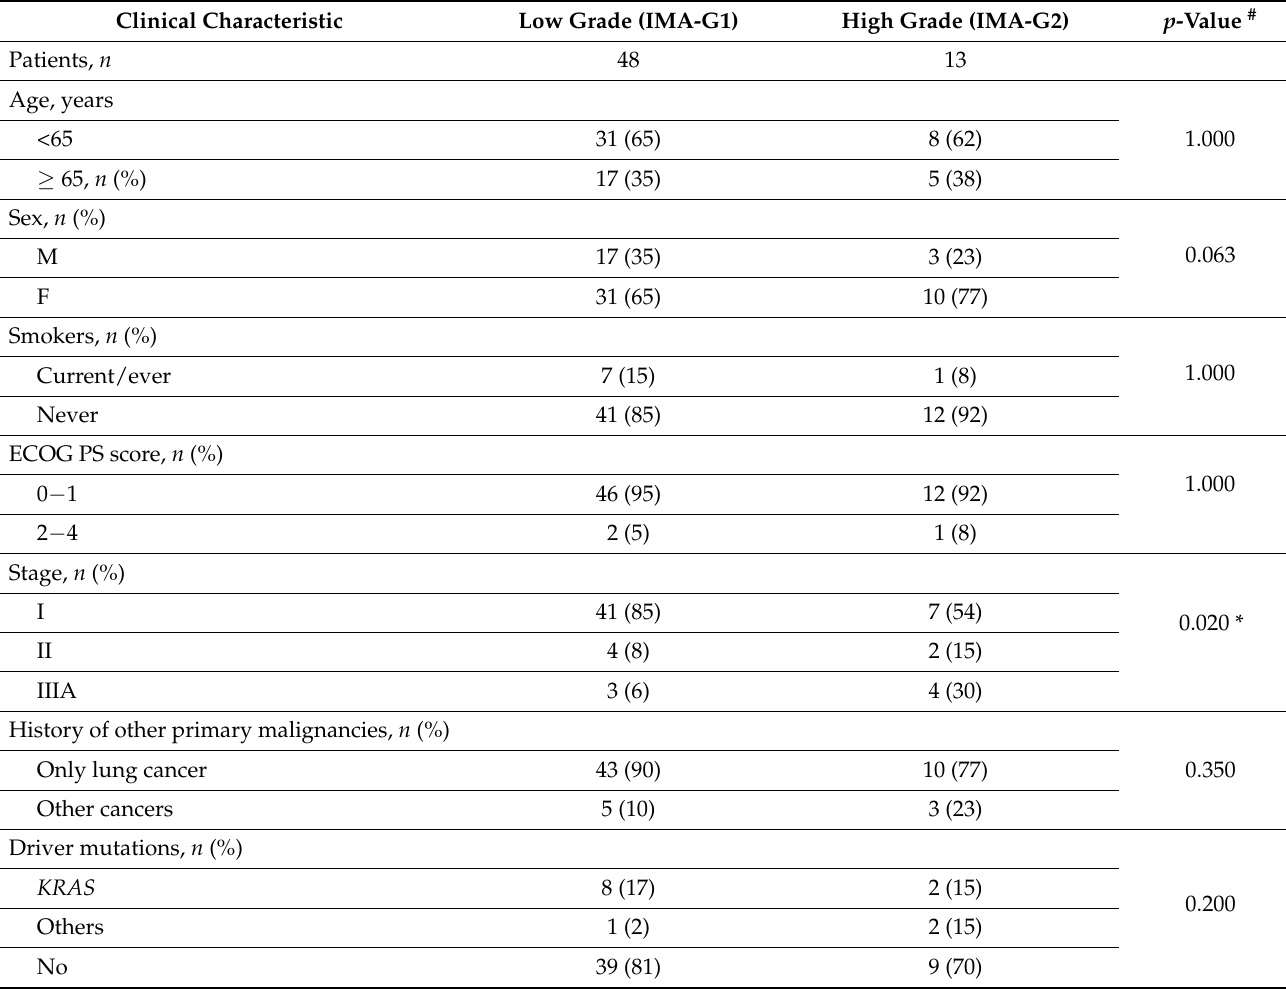
Table 4. Clinical features of low-grade IMA (IMA-G1) and high-grade IMA (IMA-G2) in stage I–IIIA pulmonary invasive mucinous adenocarcinoma ( n =